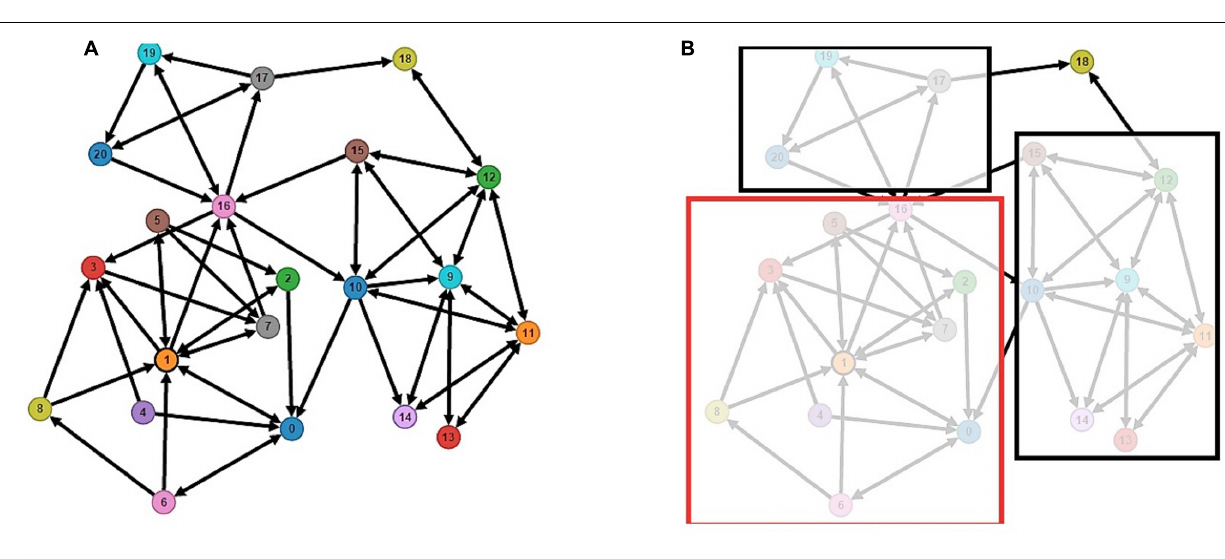
FIGURE 11 | Sociogram of the interaction. (A) The complete sociogram of the interaction. (B) The sociogram after the racial analysis. We can see how students group by